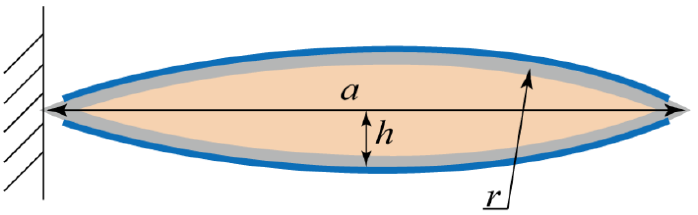
Figure 3. The cross-section view of the pouch with the original shape shown in Figure 2a. We assumed that the liquid inside the pouch remains a constant volume, and the outline of the pouch maintains a portion of a circle, where a is the lateral distance and h represents the half-thickness of the pouch. r is the radius to the outline of inactive pouch, and the electrode is attached on the whole length of the pouch.